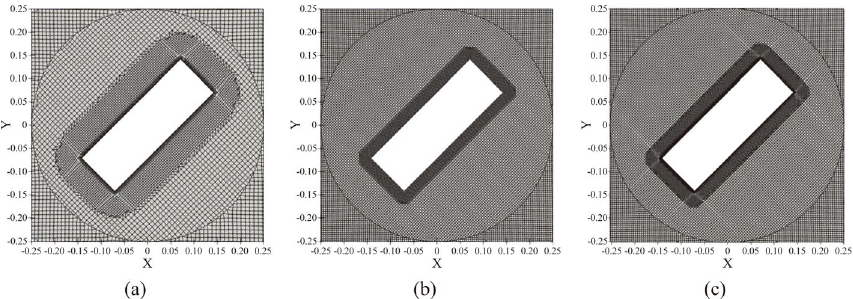
Fig. 14 The configurations of the mesh near the building: ( a ) BL, ( b ) BR and ( c ) BL_BR